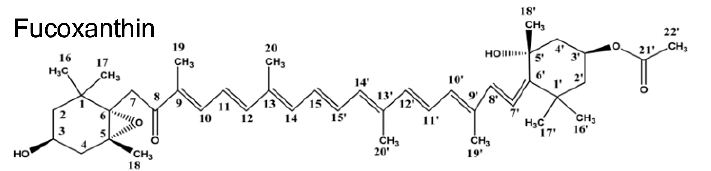
Figure 1. Chemical structure of fucoxanthin.